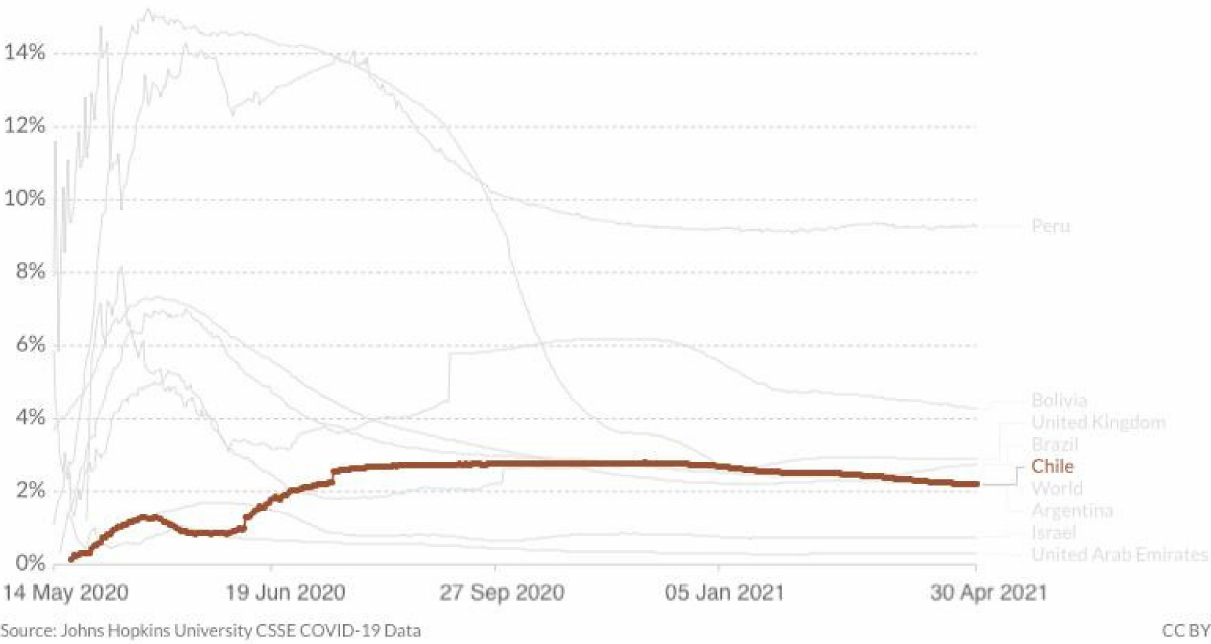
Figure 3. Case fatality rate of COVID-19 in Chile until 30 April 2021, including comparison with the region (Argentina, Brazil, Bolivia, Peru) and other leading vaccination nations (Israel, UAE, UK) www.ourworldindata.org (accessed on 1 May